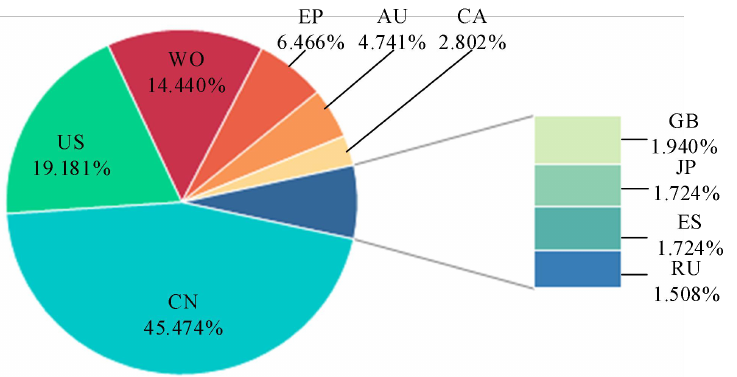
Figure 21. Number of patent applications for inventions related to precision agriculture in the last 14 years.